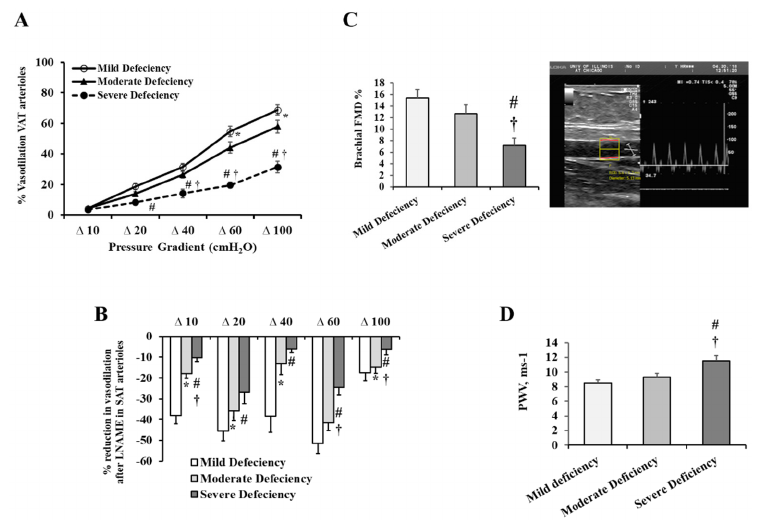
Figure 2. Vascular measurements in different VD deficiency categories. ( A ) FID measurements in VAT-isolated arterioles exposed to increasing intraluminal pressure gradients (10,100 cmH 2 O). ( B ) The percentage decrease in arteriolar FID that was caused by the inhibition of eNOS by L-NAME. ( C ) Quantification chart and representative image for brachial artery FMD measurements using Doppler ultrasound. ( D ) The carotid–femoral pulse wave velocity (PWV) in three VD deficiency groups. Results are shown as means ± standard error (SE). A significant p -value is represented by * for comparing the mild and moderate deficiency groups, # for comparing the mild and severe defi- ciency groups, and † for comparing moderate and severe de fi ciency groups. Brachial artery vasoreactivity was assessed using the Doppler ultrasound (Figure 2C). Hyperemia-induced FMD was 72% lower in subjects with severe VD deficiency com-